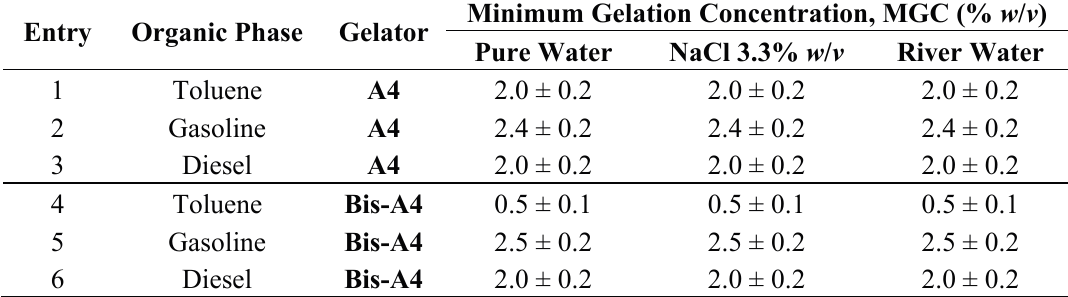
Figure 6. 1 H NMR spectra of the aqueous phases separated from D 2 O/toluene mixtures after PSG using A4 as gelator. PSG was induced by the heating-cooling method and DMF (0.1 mmol) was used as internal standard. ( A ) Solvent mixture: D 2 O/toluene (2:1 v / v ); [ A4 ] = 2.0% w / v ; ( B ) Solvent mixture: D 2 O/toluene (2:1 v / v ); [ A4 ] = 7.0% w / v . Table 3. Comparison of the MGC necessary to induce PSG in selected oil/aqueous mixtures using different aqueous